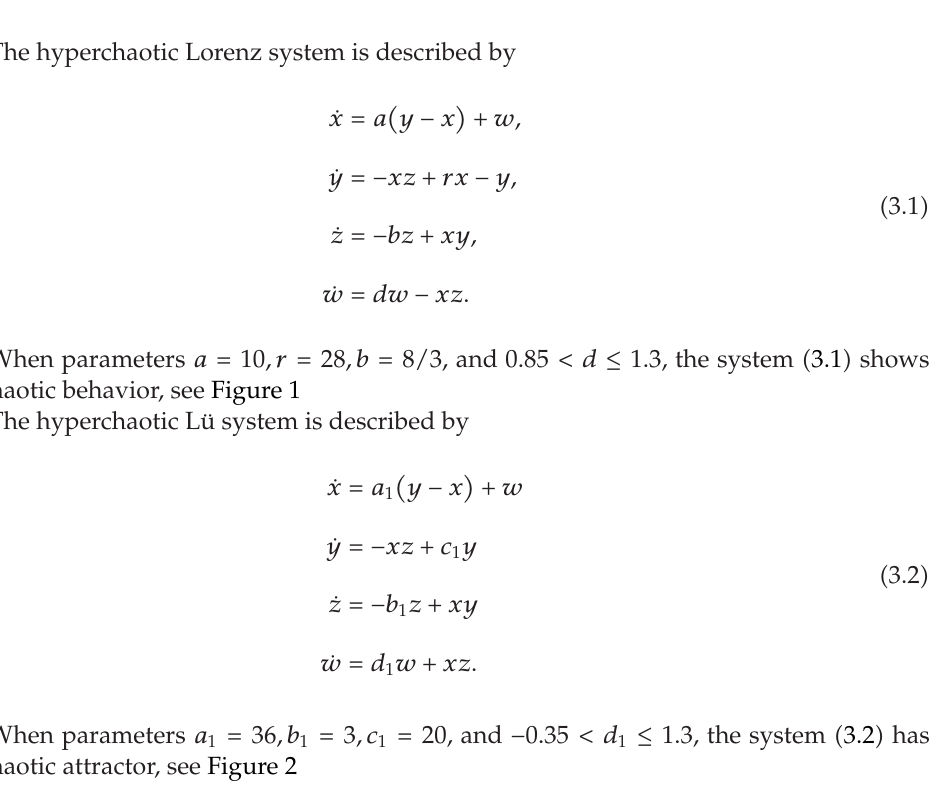
Figure 1: It shows the attractor of hyperchaotic Lorenz dynamical system at a (cid:8) 10 ,r (cid:8) 28 ,b (cid:8) 8 / 3, and d (cid:8) 1 . 3 in x,y,z